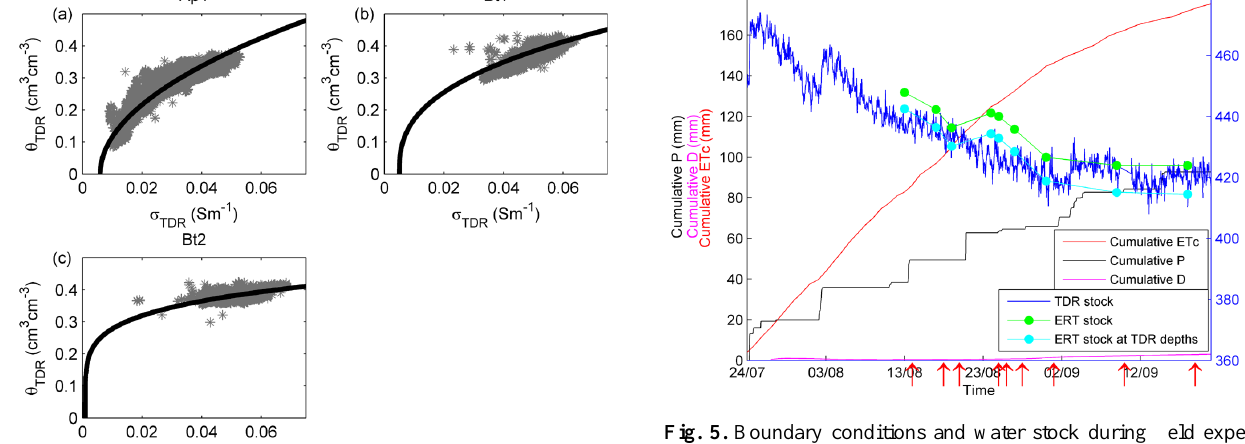
Fig. 5. Boundary conditions and water stock during field experi- mental time. Cumulative P (black), cumulative ETC (red), cumu- lative D (pink) with positive values corresponding to capillary rise and negative values to drainage, TDR water stock evolution (blue), ERT water stock (green with circles) and water stock consider- ing ERT SWC at the four TDR depths (10cm, 30cm, 70cm and 125cm) and integrated as for TDR water stock (cyan circle). Red arrows represent the ERT measurement